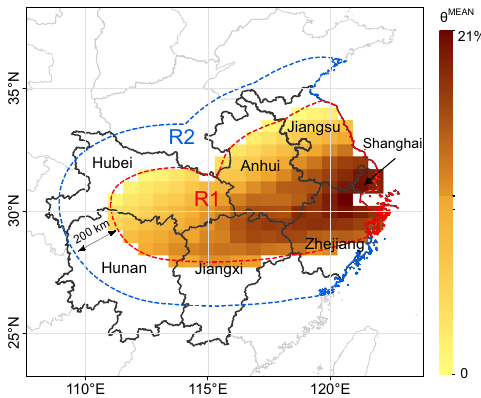
Fig. 2 Spatial distributions of the impact degree within the affected region (R1). The region enclosed within the red dashed line is R1. The region between the red and blue dashed lines is the unaffected surrounding region (R2). θ MEAN denotes the impact degree of plum rain on the surface irradiance at a given location.